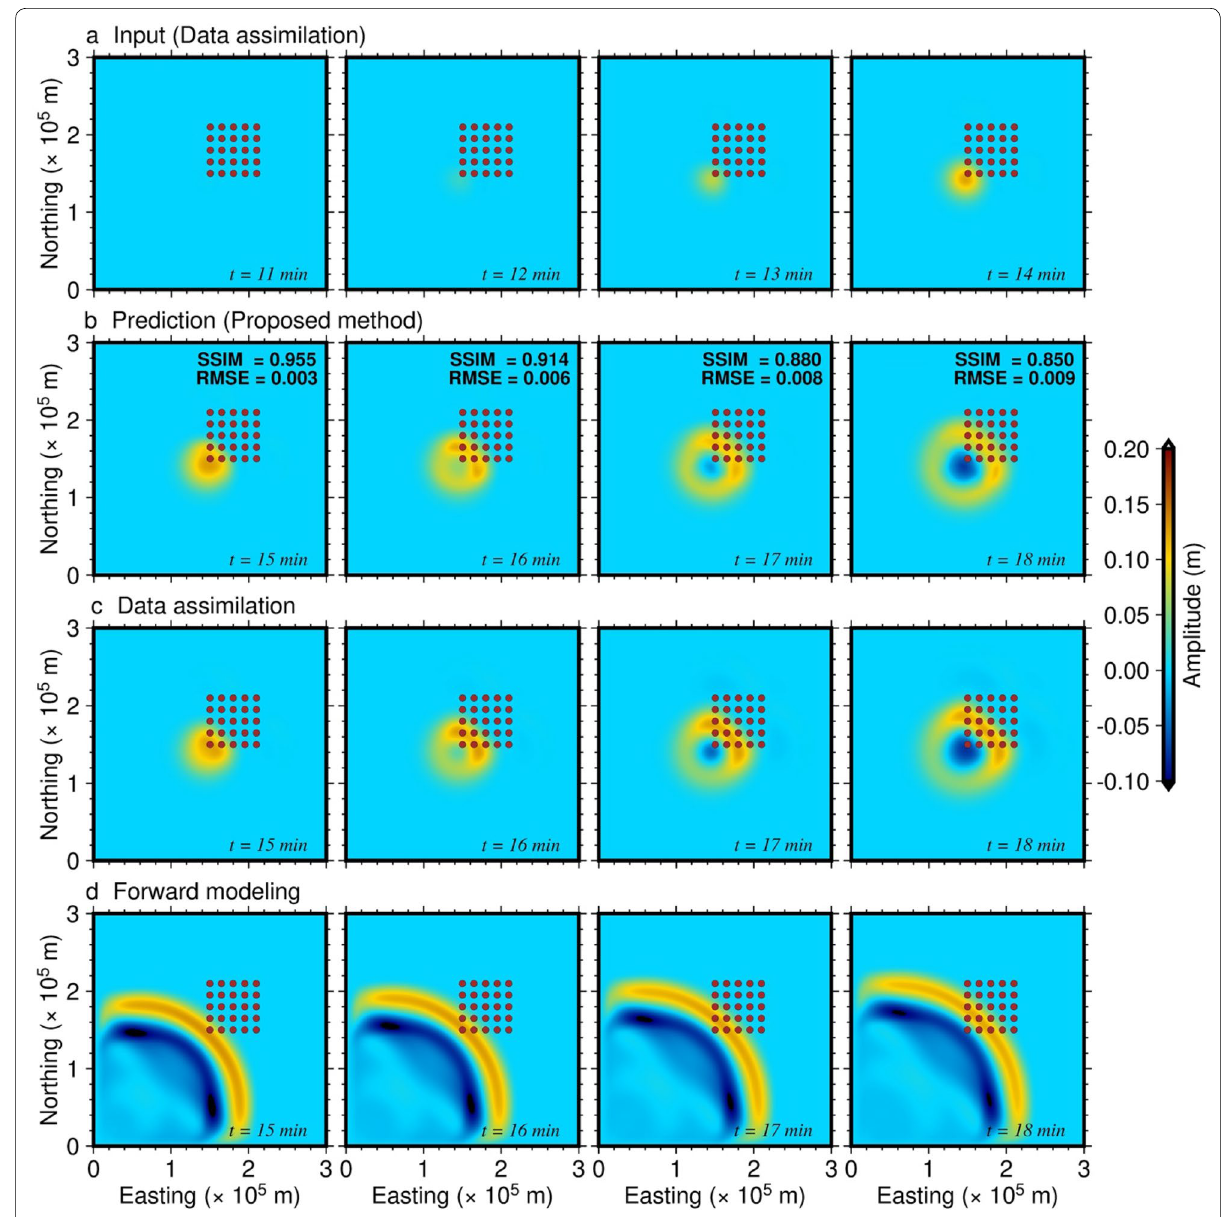
Fig. 4 Comparisons of the wavefields for the model input and the estimated wavefields from the proposed method, DA and forward modeling for the simple bathymetry case. a Input to the model; b forecasted tsunami wavefields; c assimilated tsunami wavefields; d results of forward